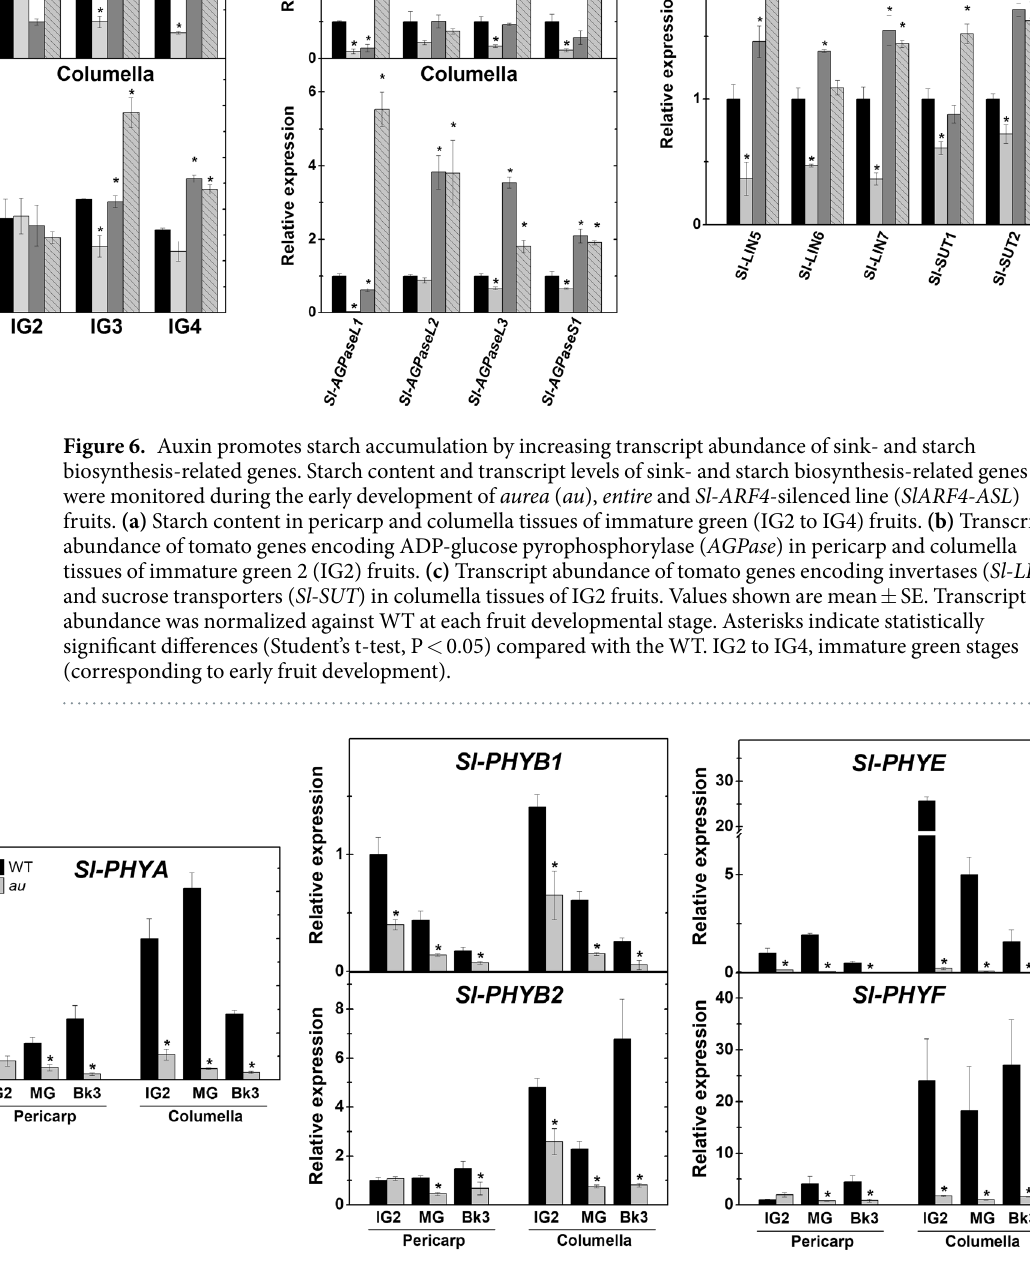
Figure 7. Deficiency in phytochromobilin downregulates PHY-encoding genes. Relative mRNA levels of the five tomato genes encoding phytochromes ( Sl-PHY ) in the pericarp and columella tissues of wild type (WT) and aurea ( au ) fruits harvested at immature (IG2), mature green (MG) and ripening (Bk3) stages. Mean relative expression was normalized against pericarp WT samples at IG2 stage. Values shown are mean ± SE. Asterisks indicate statistically significant differences (Student’s t-test, p < 0.05) between au and WT at each fruit development